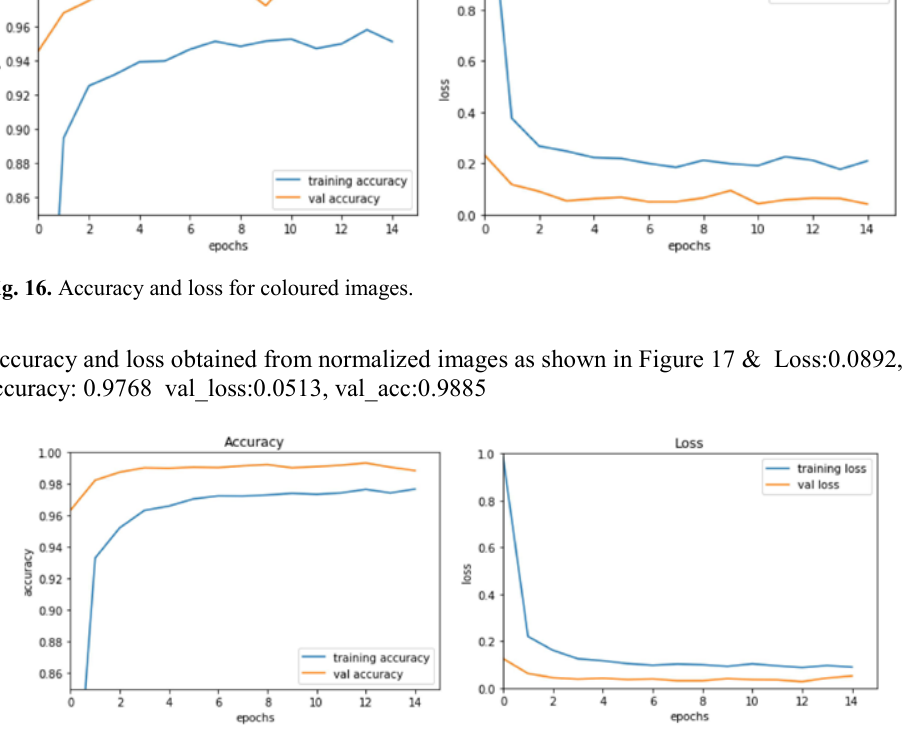
Fig 17. Accuracy and loss for normalized images.